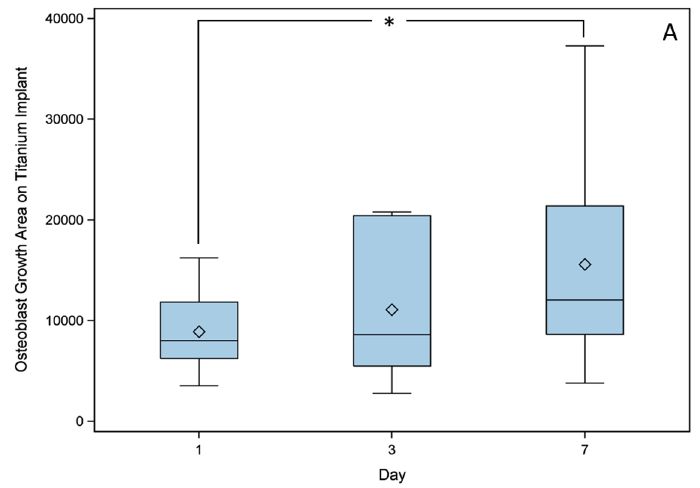
Figure 2. Cross section of titanium implant with green fluorescent protein (GFP)–osteoblasts settled for ( A ) one day; ( B ) three days; and ( C ) seven days. Cells were placed on the top of the implant (marked 0 µm). The distance between the horizontal lines is 100 µm. Pores are marked red and counted cells orange (Wimasis Image